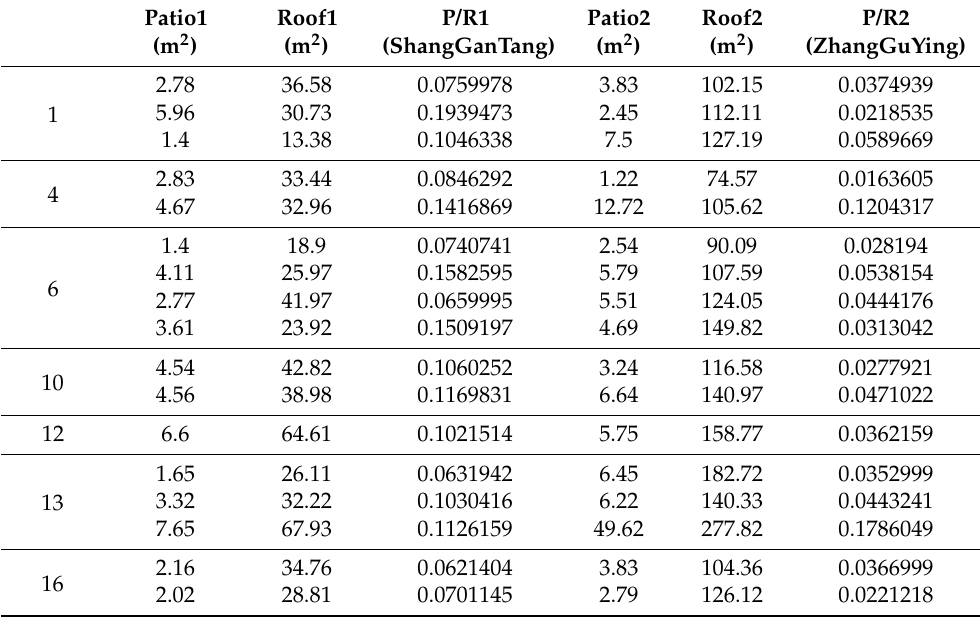
Table 2. The table of the 3D model water catchment area measurement.